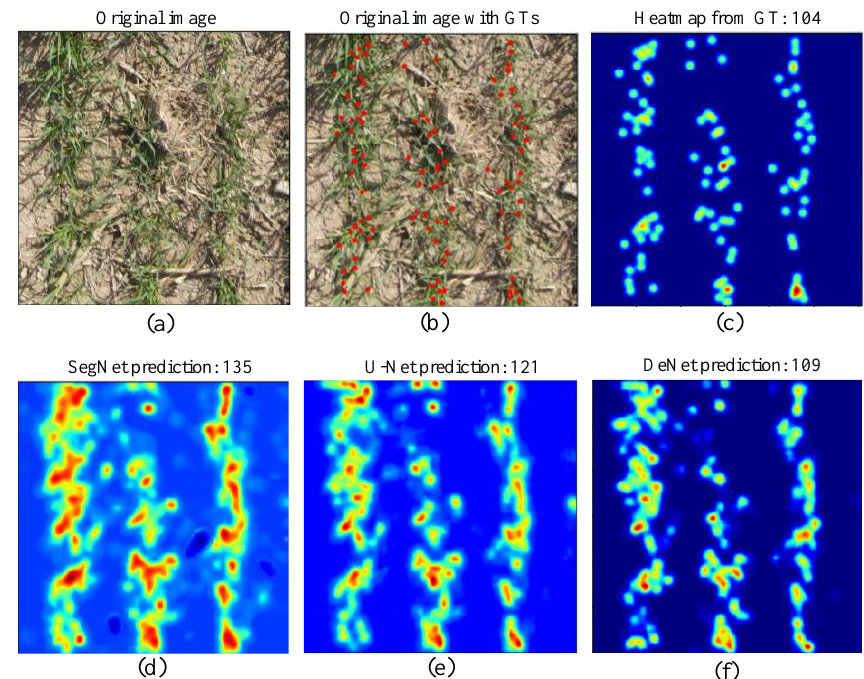
Figure 5. Examples of model prediction from three models. ( a ) An example of an original image patch in the validation dataset. ( b ) Original image patch with annotations. ( c ) Heatmap generated from annotations. ( d ) Heatmap predicted by SegNet. ( e ) Heatmap predicted by U-Net. ( f ) Heatmap predicted by DeNet. The number in the upper image indicates plant density in the image patch (ground-truth or prediction).